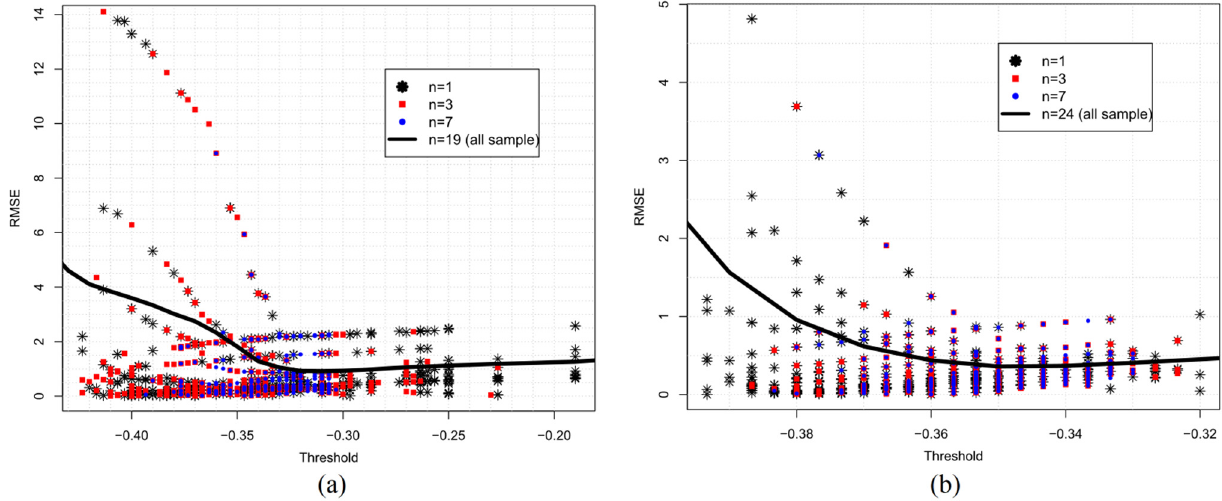
Figure 6. Scatter plot errors obtained from mimicked cross-validation: ( a ) Landsat-8 and ( b ) Sentinel-2 images.